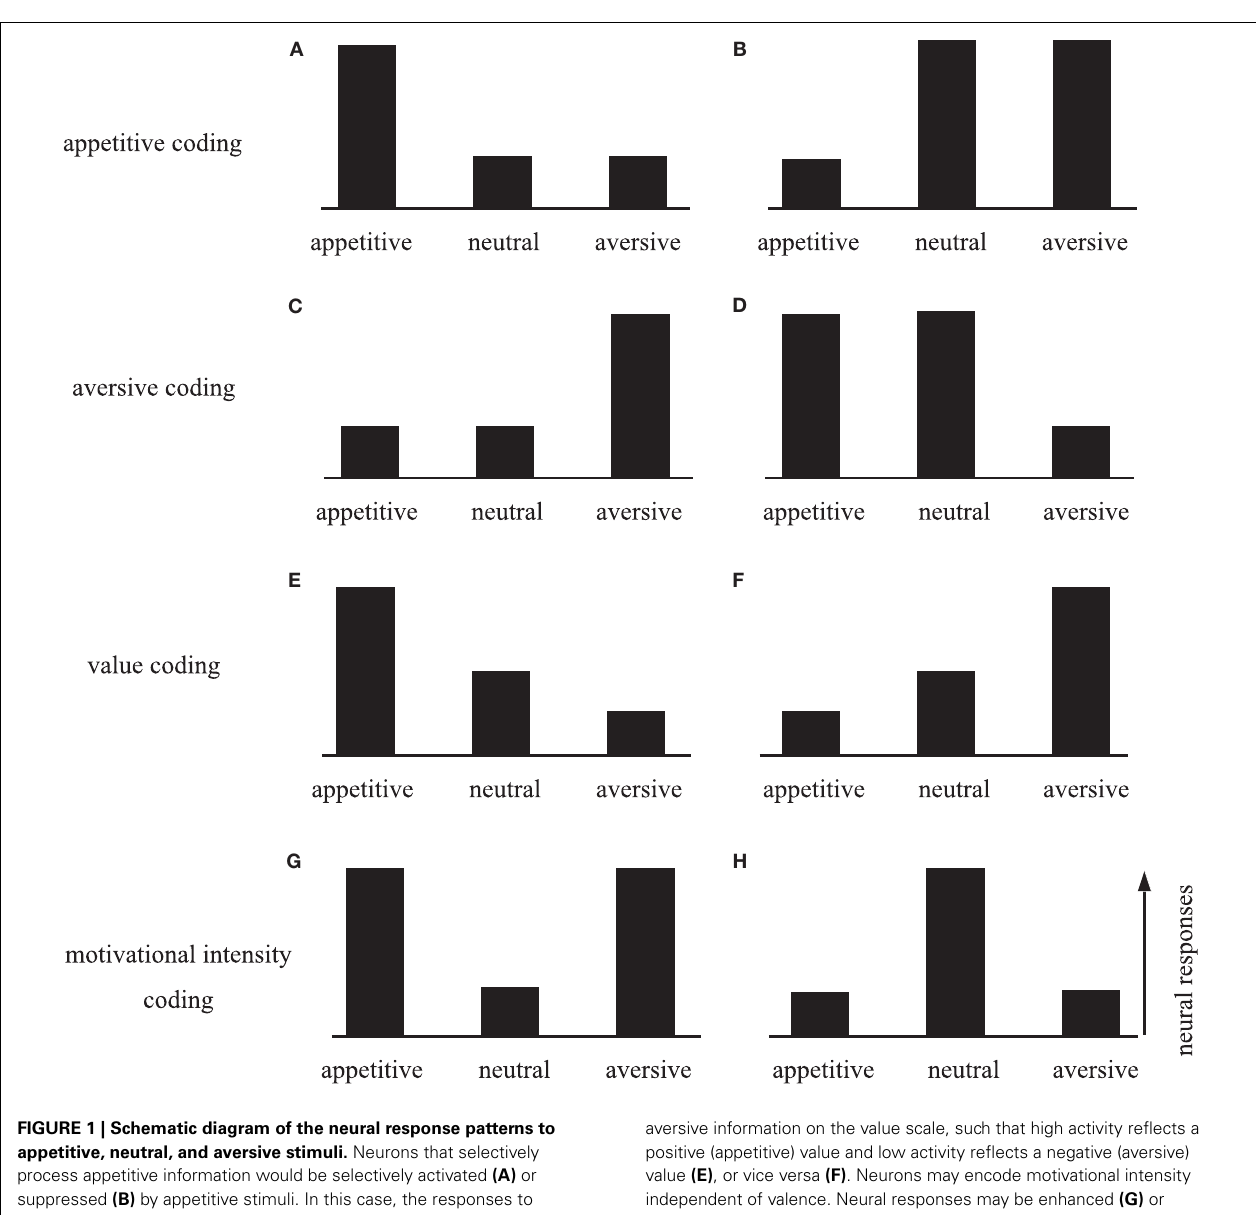
FIGURE 1 | Schematic diagram of the neural response patterns to appetitive, neutral, and aversive stimuli. Neurons that selectively process appetitive information would be selectively activated (A) or suppressed (B) by appetitive stimuli. In this case, the responses to aversive and neutral stimuli would not differ. Similarly, neurons in the aversive system would exhibit selective activation (C) or suppression (D) to aversive stimuli. Single neurons may encode both appetitive and